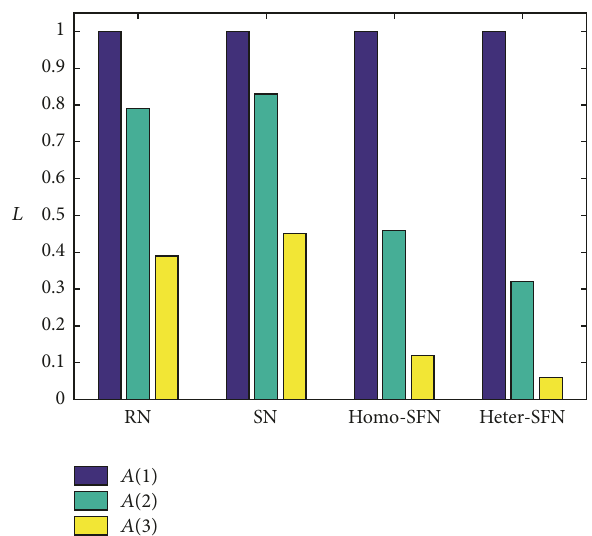
Figure 12: 𝐿 - 𝜀 relation curve under max-degree attack (𝑅 = 1) .